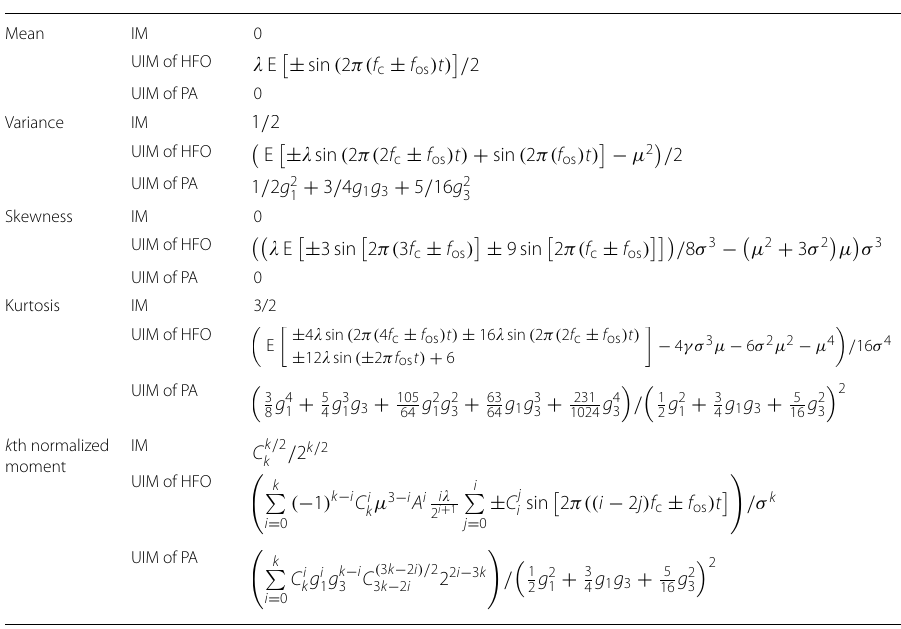
Table 3 Statistics of sinewave signals